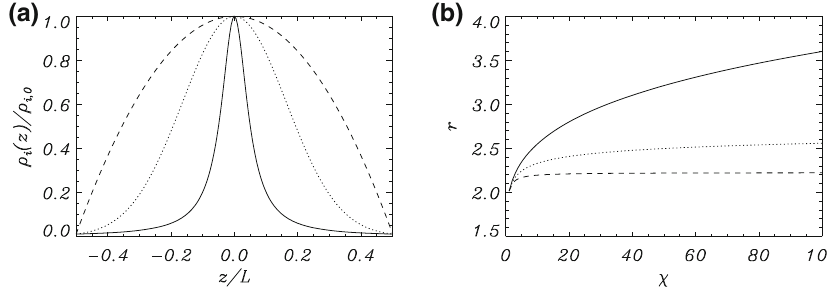
Fig. 88 a Spatial variation of the equilibrium mass density along the magnetic flux tube for prominence thread models with a Lorentzian profile (solid line), a Gaussian profile (dotted line) and a parabolic profile (dashed line). The ratio of centre to foot-points densities is χ = 100. b Dependence of the numerically computed period ratio r = P 1 / P 2 with χ for the Lorentzian profile (solid line), the Gaussian profile (dotted line) and the parabolic profile (dashed line). For these computations the tube length to radius ratio is L / R = 100 and the density contrast is ζ = 100. P 1 and P 2 denote the periods of a homogeneous thread with ρ i = ρ i , 0 . Image adapted from Soler et al.